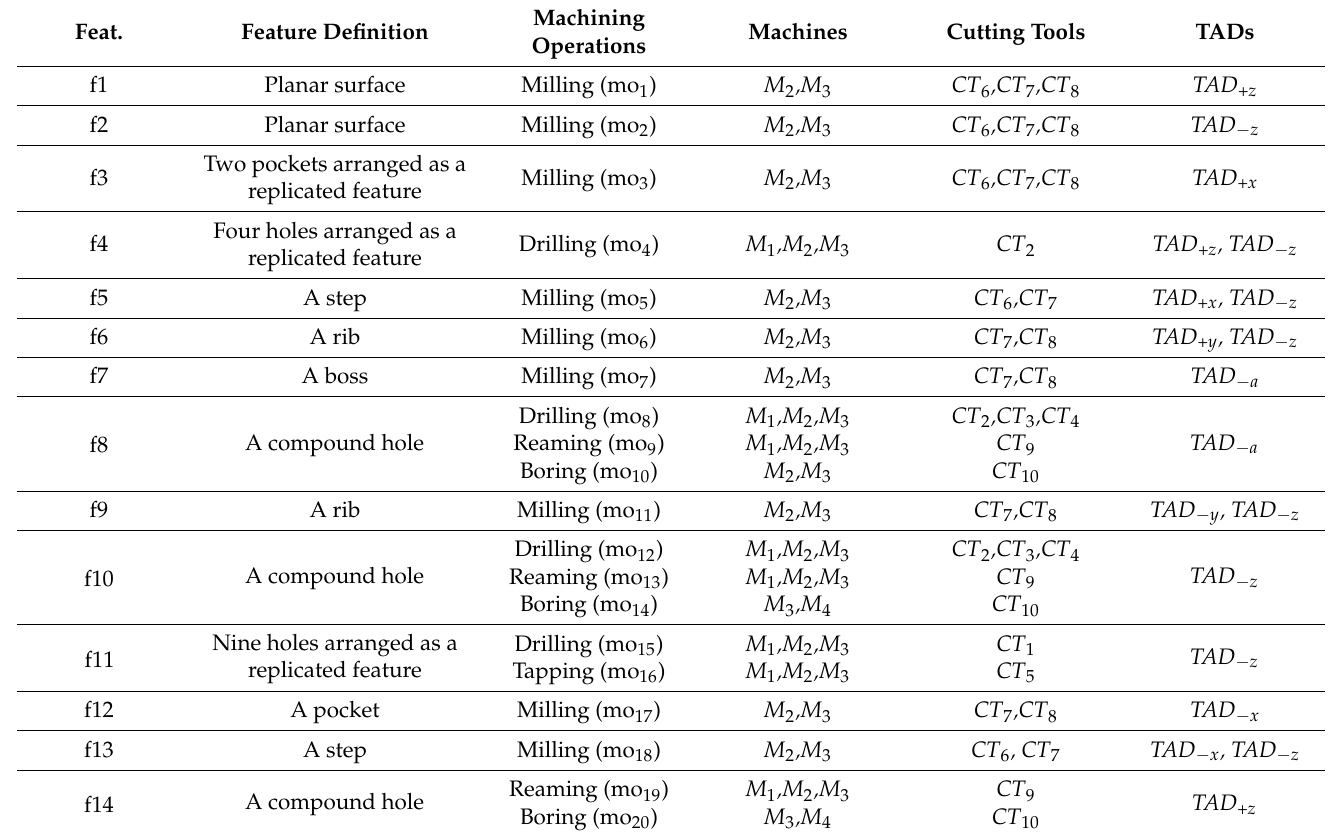
Table 1. Information about features and resource candidates for prismatic part